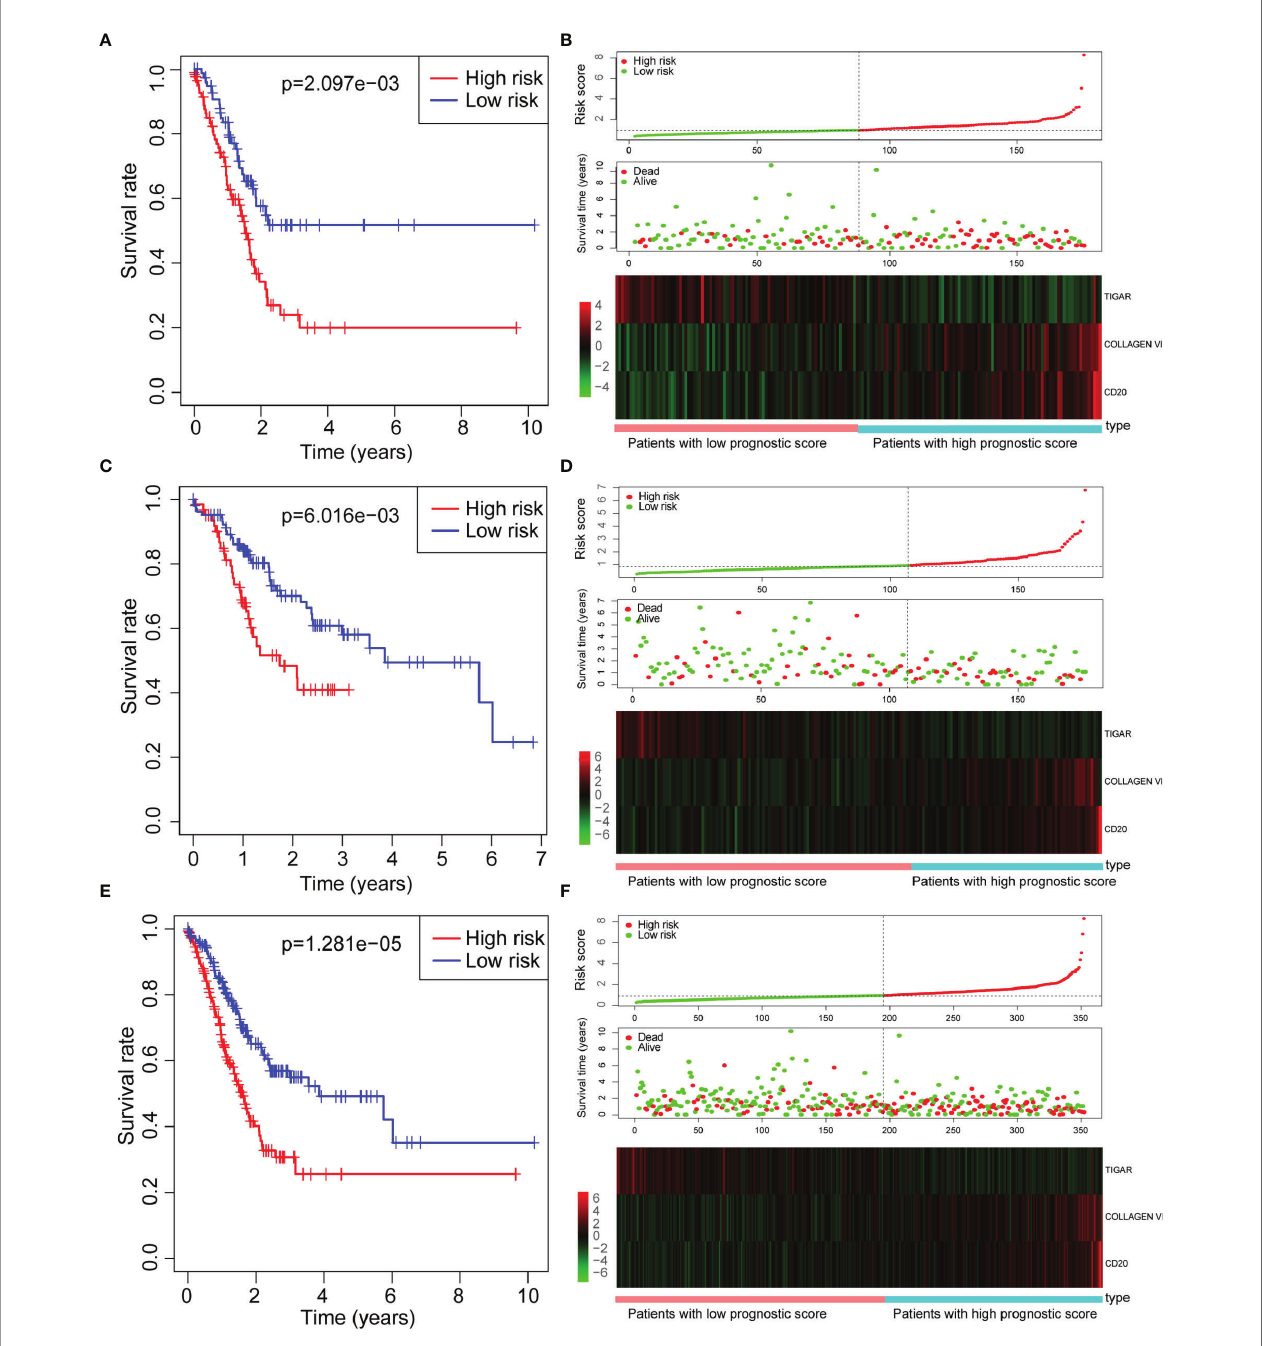
FIGURE 4 | Assessment of prognostic risk models. (A, B) Training set; (C, D) Testing set; (E, F) All set. (A, C, E) Kaplan-meier survival curve; (B, D, F) Risk score, scattered plots of survival time, and heat map of related proteins expression Note: Abscissa indicates cumulative frequency, and ordinate represents survival time (month). The green circle represents those alive, and the blue diamond represents deaths. The single in fl ection point of the risk score curve is marked by the dotted line. The gastric cancer patients were categorized into two groups: low risk group and high risk